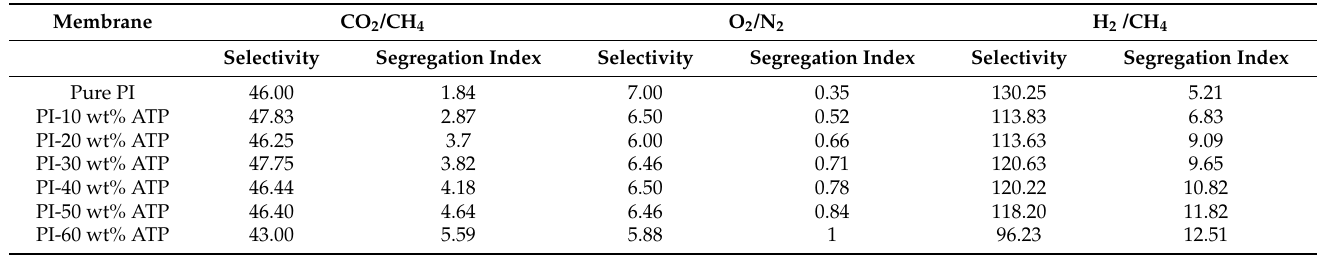
Table 1. Selectivity of pure polyimide and nano ATP polyimide composite membranes.